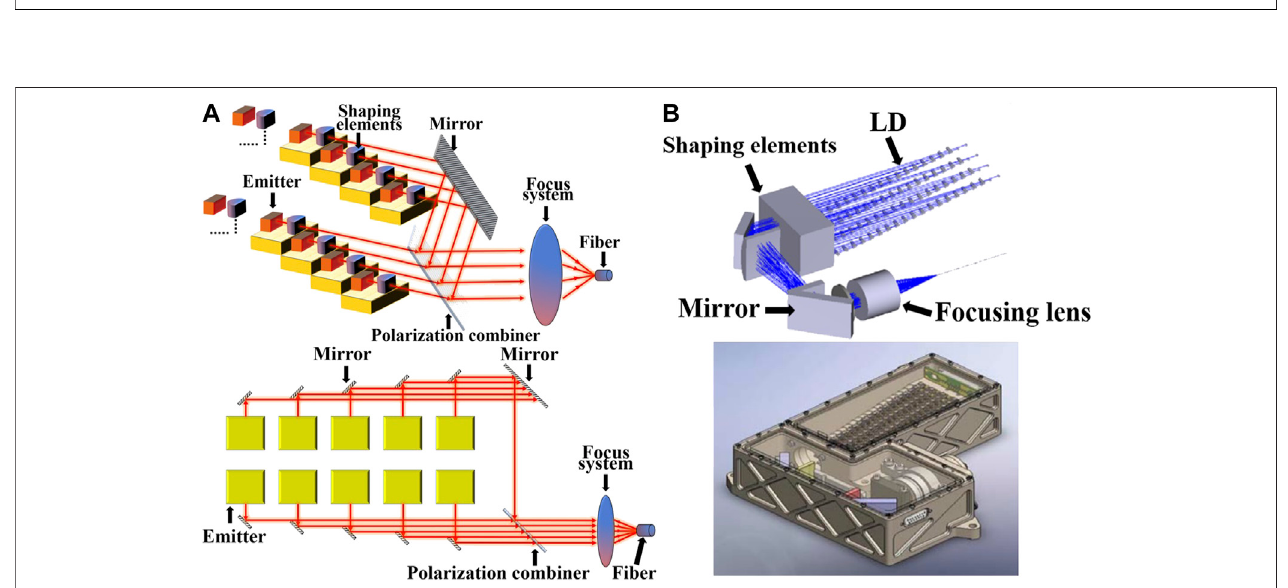
FIGURE 5 | (A) Single-emitter based beam combining system using spatial and polarization superposition. Adapted from [1]; Beam combining system for 56 single-emitter array sources. Adapted from